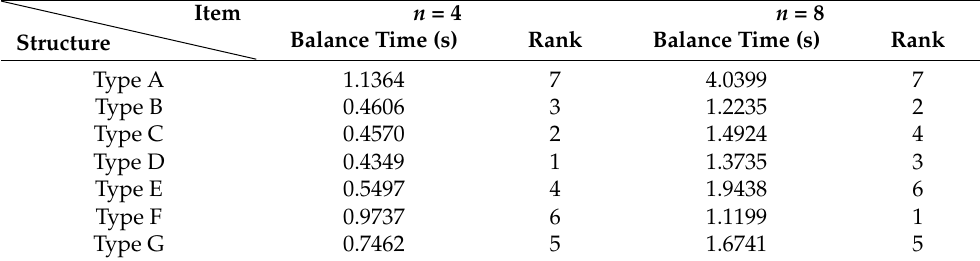
Table 6. Averaged balancing times for 4 and 8 cells and their rankings when using different equaliza- tion structures. Structure